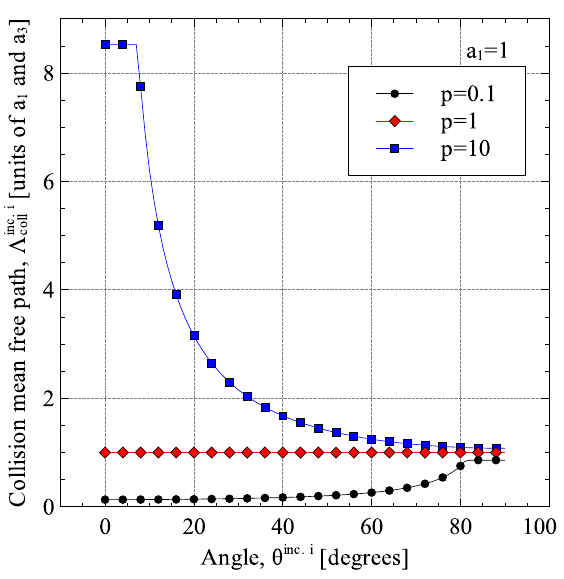
Figure 4. Variation of collision mean-free-path Λ (cid:3030)(cid:3042)(cid:3039)(cid:3039)(cid:3036)(cid:3041)(cid:3047).(cid:3036) with angle (cid:2016) (cid:3036)(cid:3041)(cid:3030).(cid:3036) .